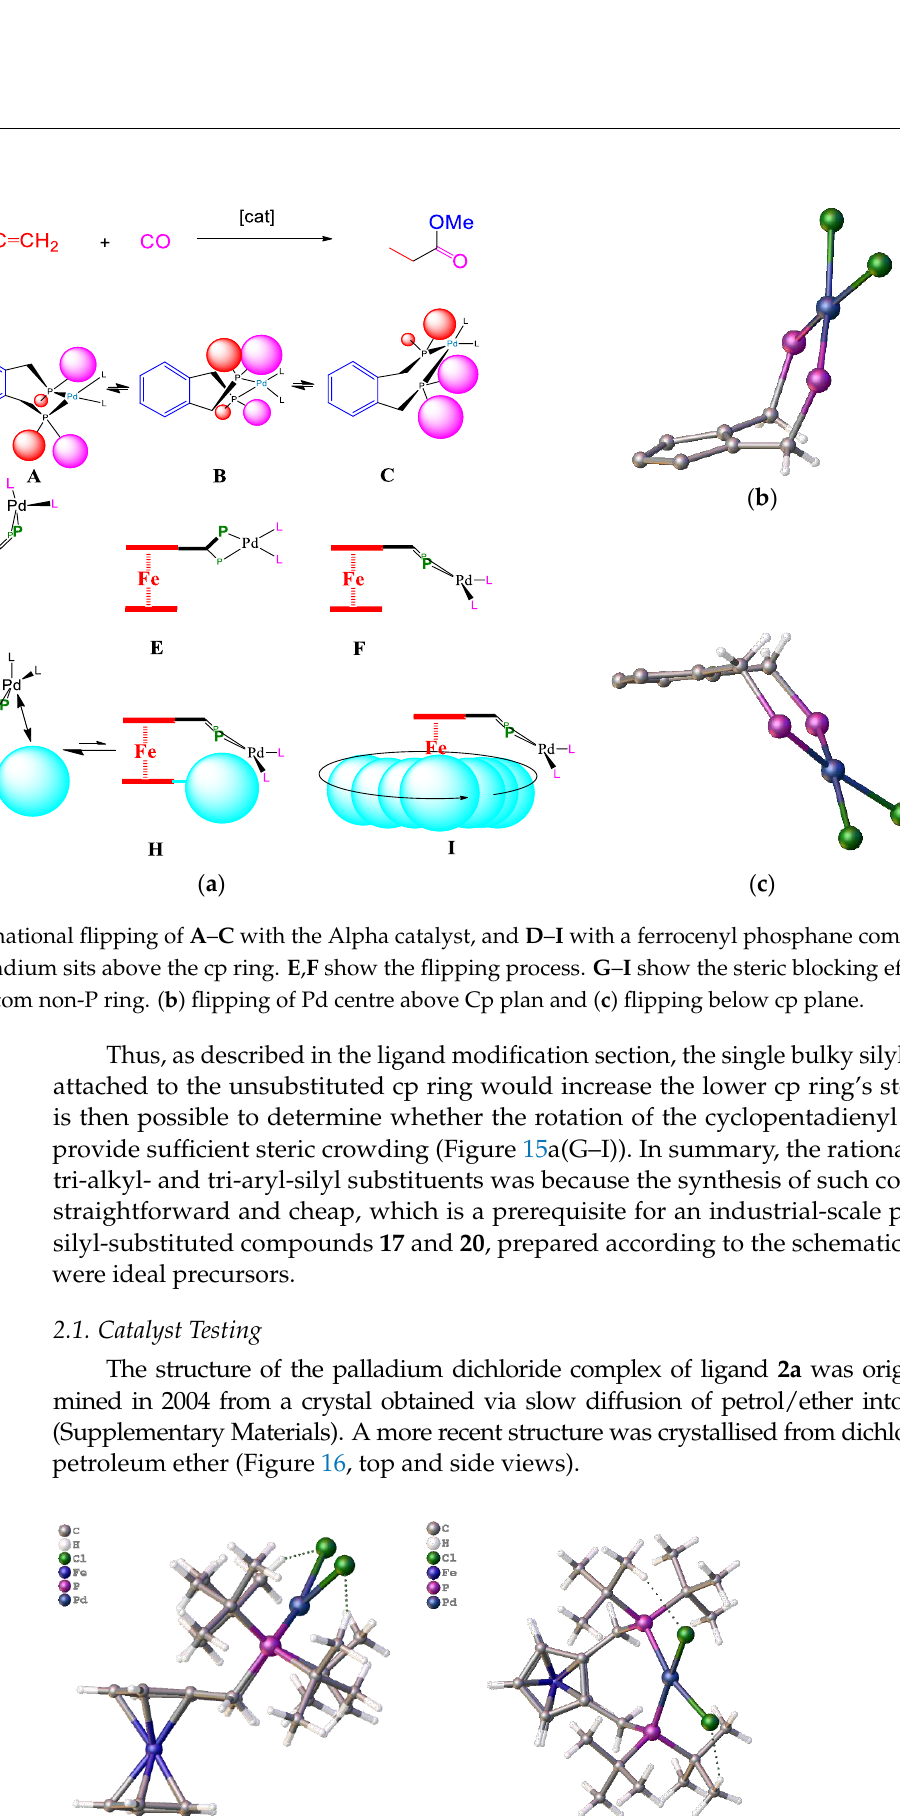
Figure 14. Conformational scheme for the Alpha ligand palladium complex, showing conforma- tional flipping.